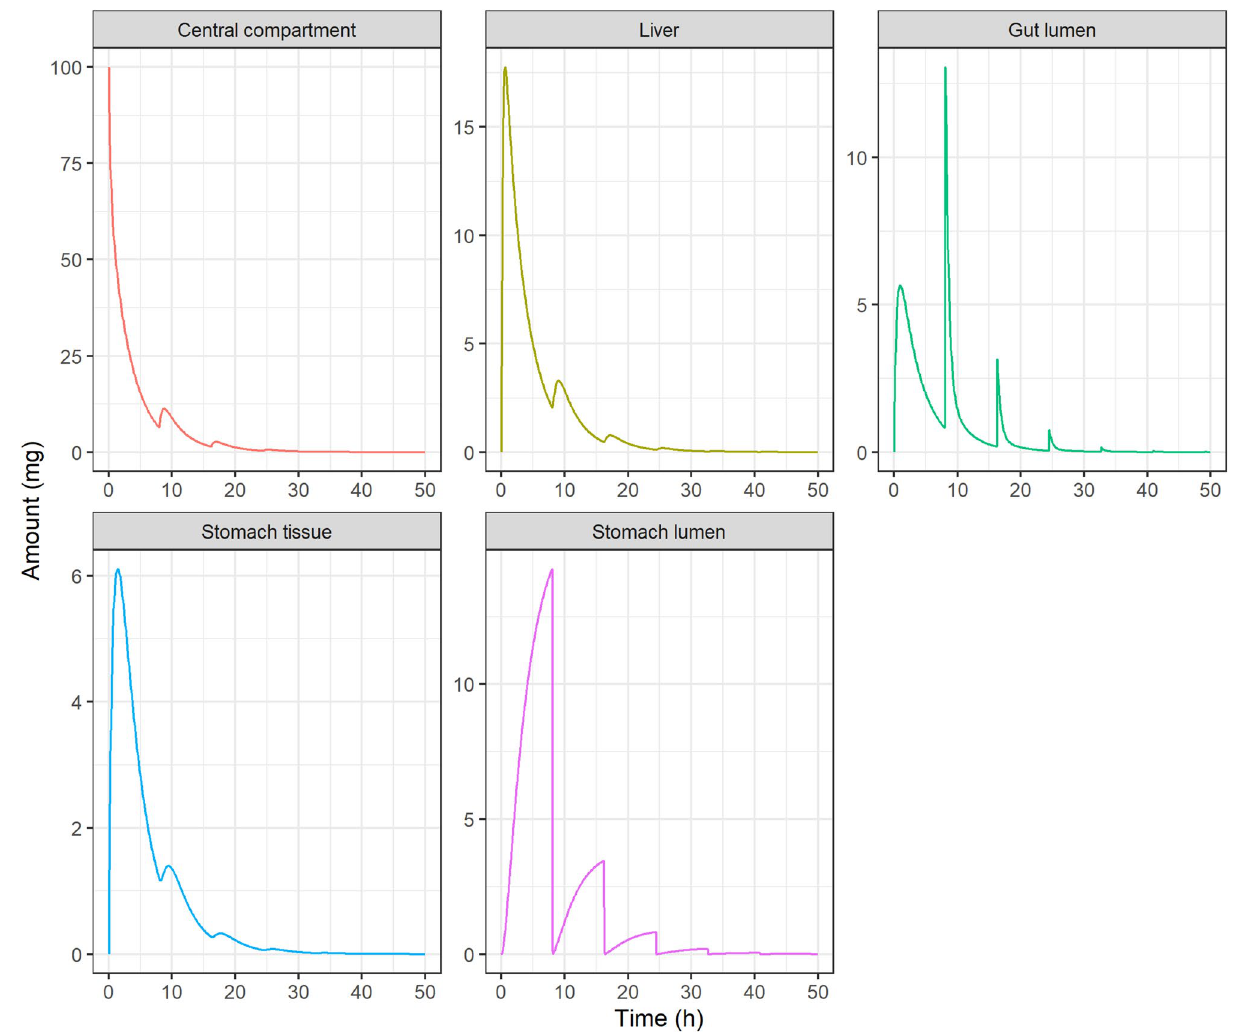
Figure 4. Pharmacokinetic profiles simulated for an intravenous administration of 100 mg, drug A, in the EGR model. Drug amounts in the central compartment ( A C ), stomach tissue ( A S ), liver ( A H ), gut lumen ( A G ) and stomach lumen ( A SL ) are plotted versus time after dose. The multiple-peaking nature of the profiles corresponds to discrete gastric emptying events taking place every 8 h after with meal intake and followed by drug reabsorption into the central